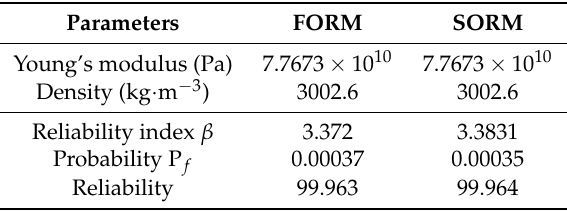
Table 6. Reliability